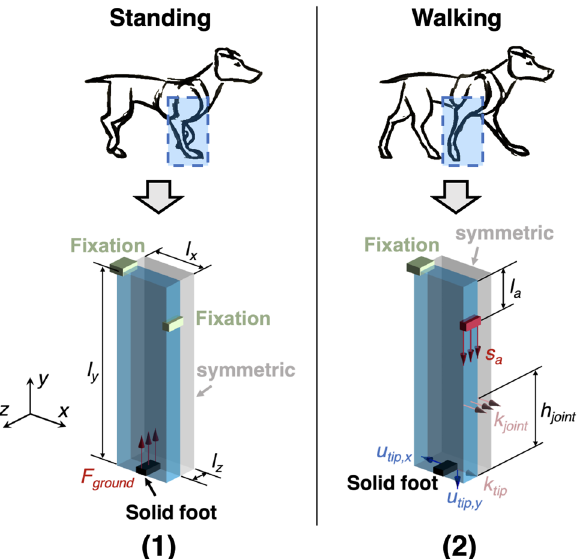
Figure 2. Two loading cases of the compliant leg for the proposed multi-objective topology optimization method: (1) The standing position of the leg, (2) The walking (bending) position of the